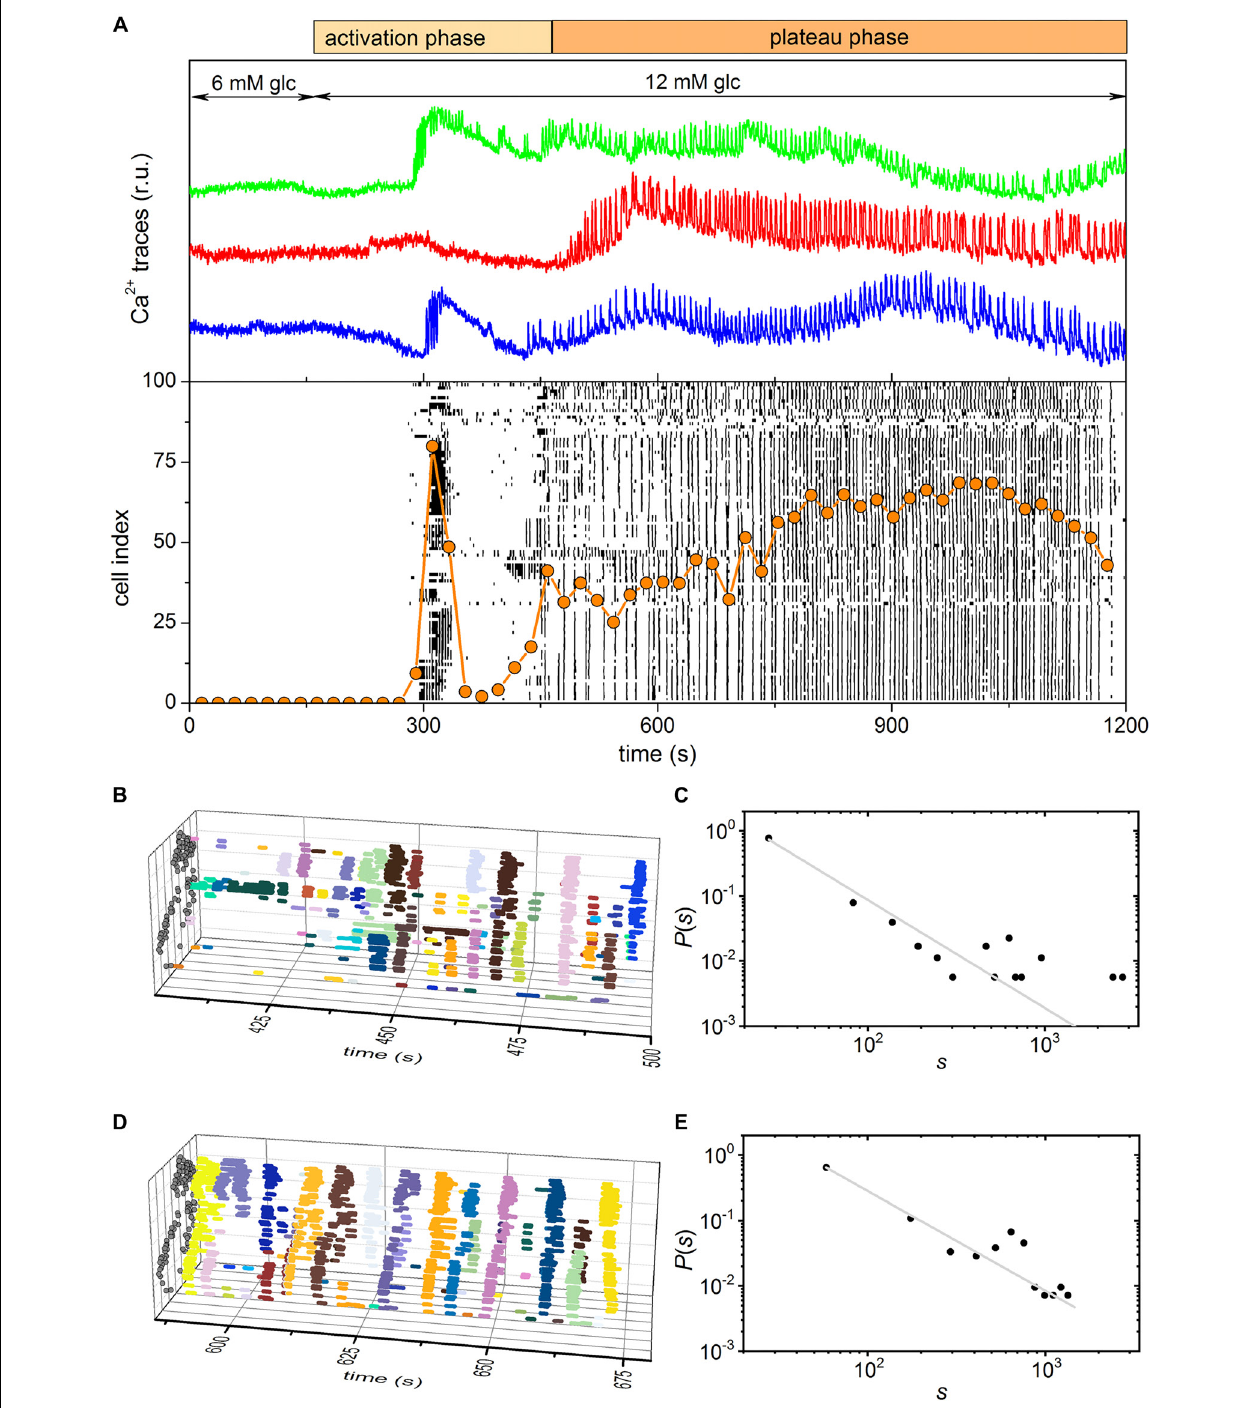
FIGURE 5 | Experimentally measured beta cell responses after stimulation with 12 mM glucose. (A) Three characteristic Ca 2 + traces and the raster plot of binarized signals of Ca 2 + oscillations in all cells in the islet. The orange dotted line indicates the fraction of active cells within the given time-window that was slid throughout the recording. (B,D) 3D raster plots showing the Ca 2 + waves for selected intervals for the activation (B) and plateau (D) phase. Colors denote specific Ca 2 + events. Gray dots on the y , z plane stand for coordinates of cells. (C,E) The distributions of Ca 2 + wave sizes for the activation (C) and plateau (E) phase. The gray dashed line indicates the power-law